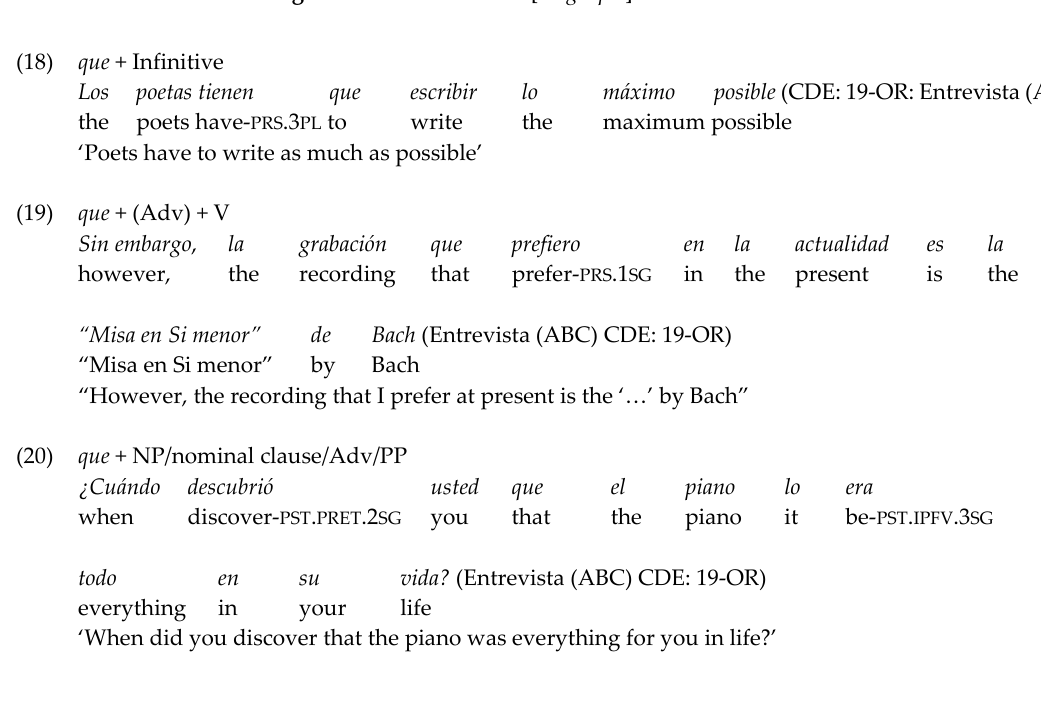
Table 3. The three main linguistic items following que (N = 1983).